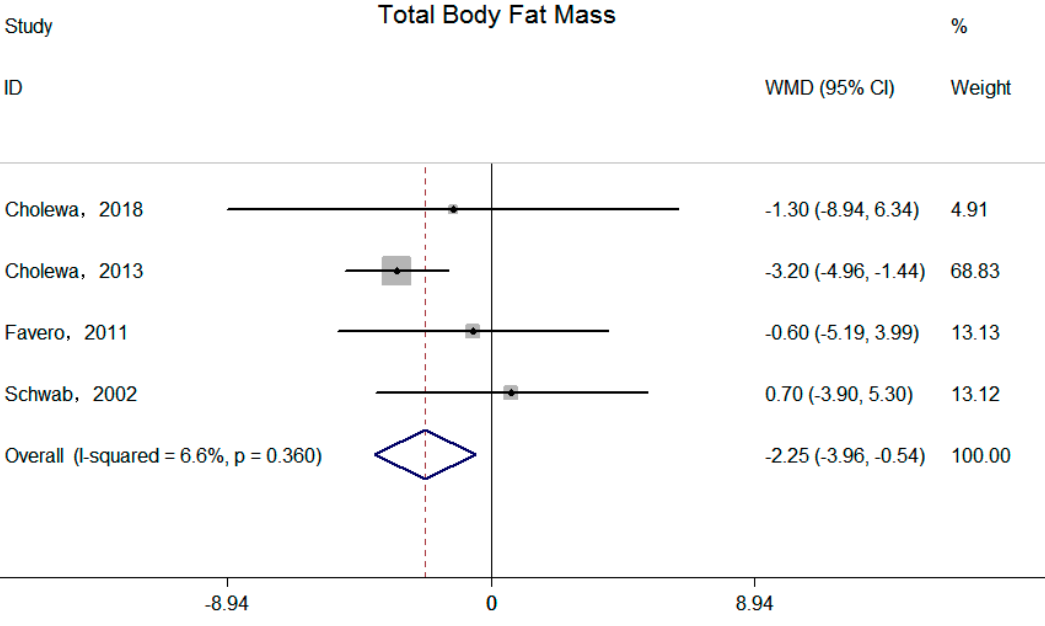
Figure 4. E ff ects of supplemental betaine on total body fat mass in participants. The pooled e ff ect was calculated by using a random-e ff ects model. The diamonds denote the summary risk estimate, and the horizontal lines represent the 95%